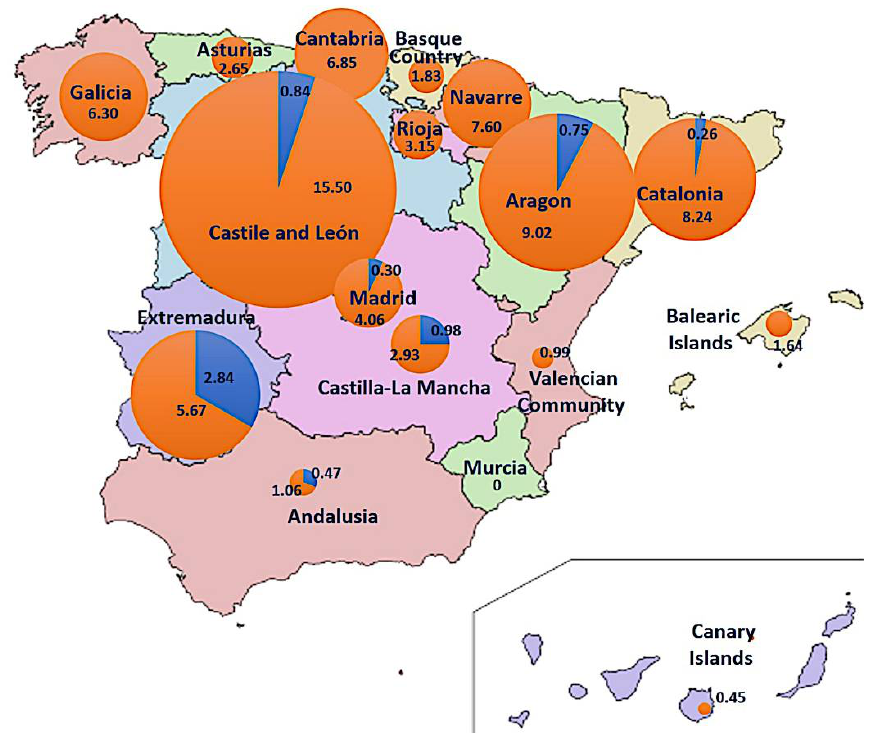
Figure 10. Cumulative incidence of phalloidian poisonings in Spain per region and season (blue: spring, orange: autumn). Values indicate Incidence (per million of habitants) in 1997–2020 period (circumference radius are proportional to the incidence value).